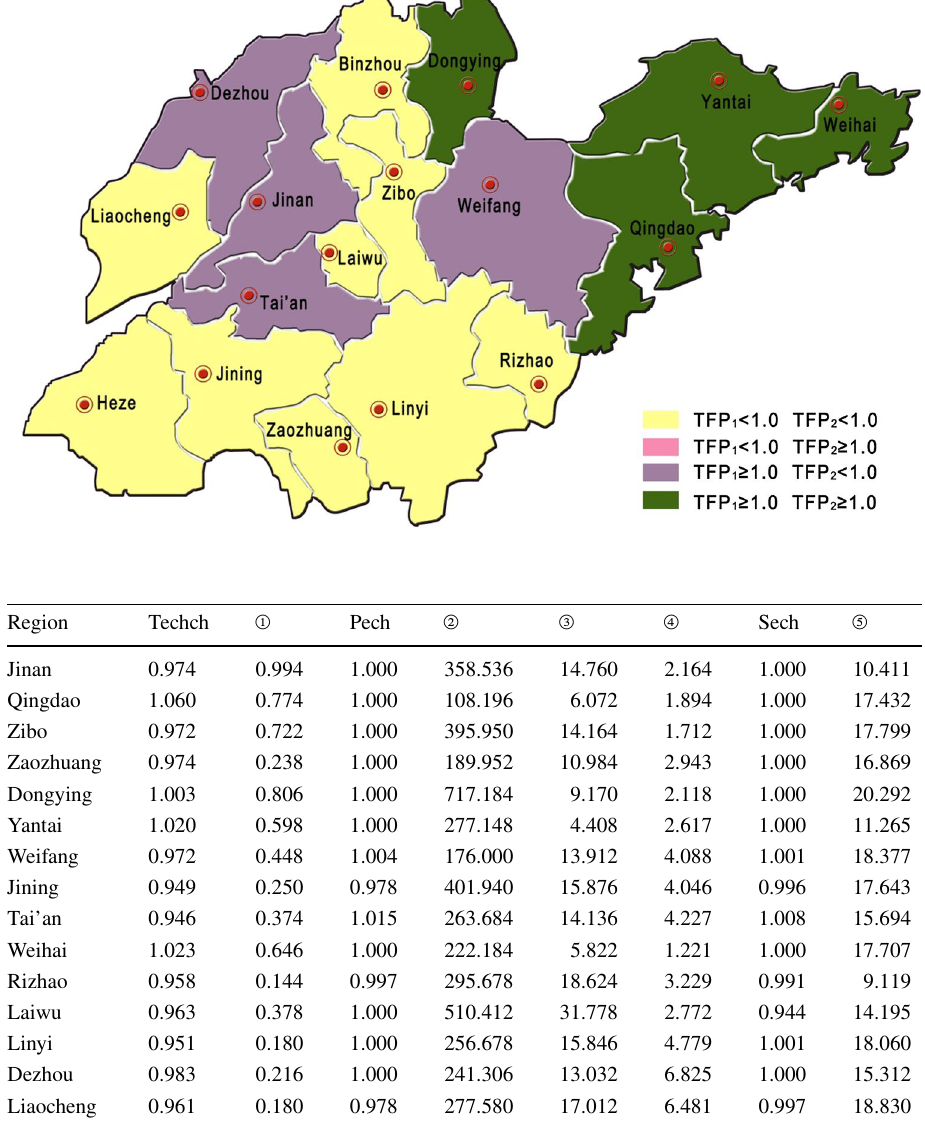
Fig. 4 Spatial distribution of TFP of 17 cities during the 11th and 12th Five-year Plan periods. Note : TFP1 and TFP2 refer to the results from the 11th and 12th Five-year Plan period, respectively